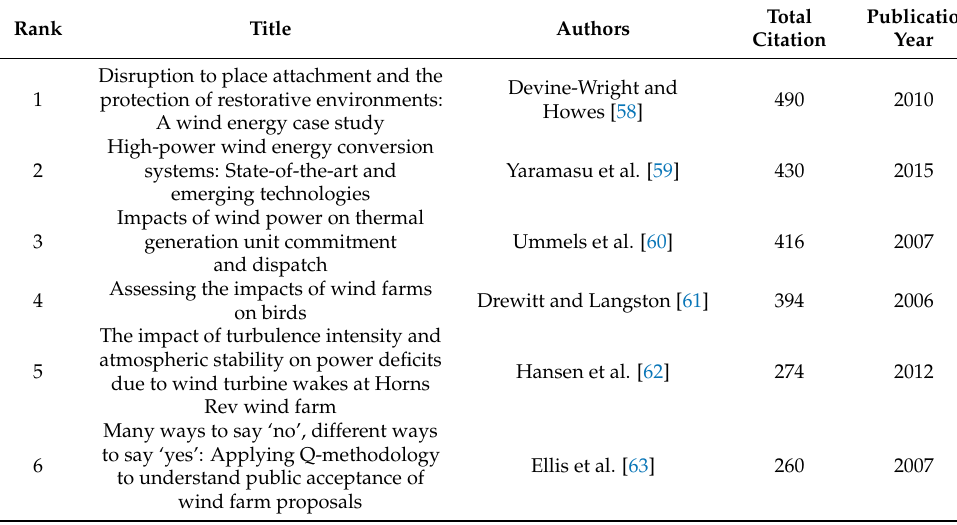
Table A2. A summary of the top 10 most highly cited research articles in